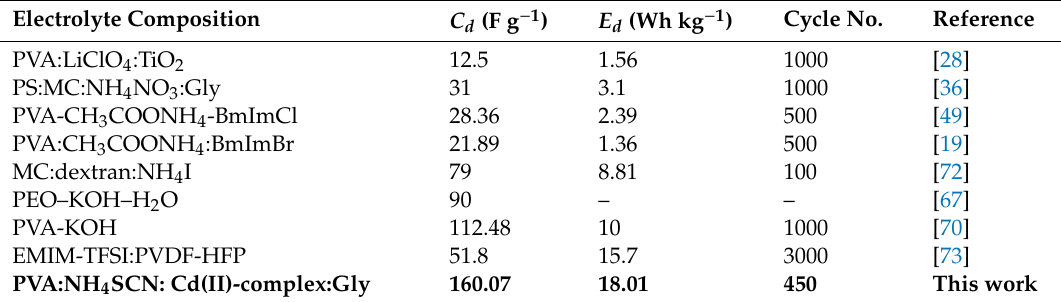
Figure 9. ( a ) Specific capacitance (C d ) of the manufactured EDLC for 450 cycles and ( b ) equivalent series resistance (ESR) pattern for 450 cycles. Table 6. Electrical double-layer capacitors (EDLCs) specific capacitance ( C d ), energy density ( E d ), as well as cycle numbers using dissimilar polymer electrolytes (PEs) at surrounding